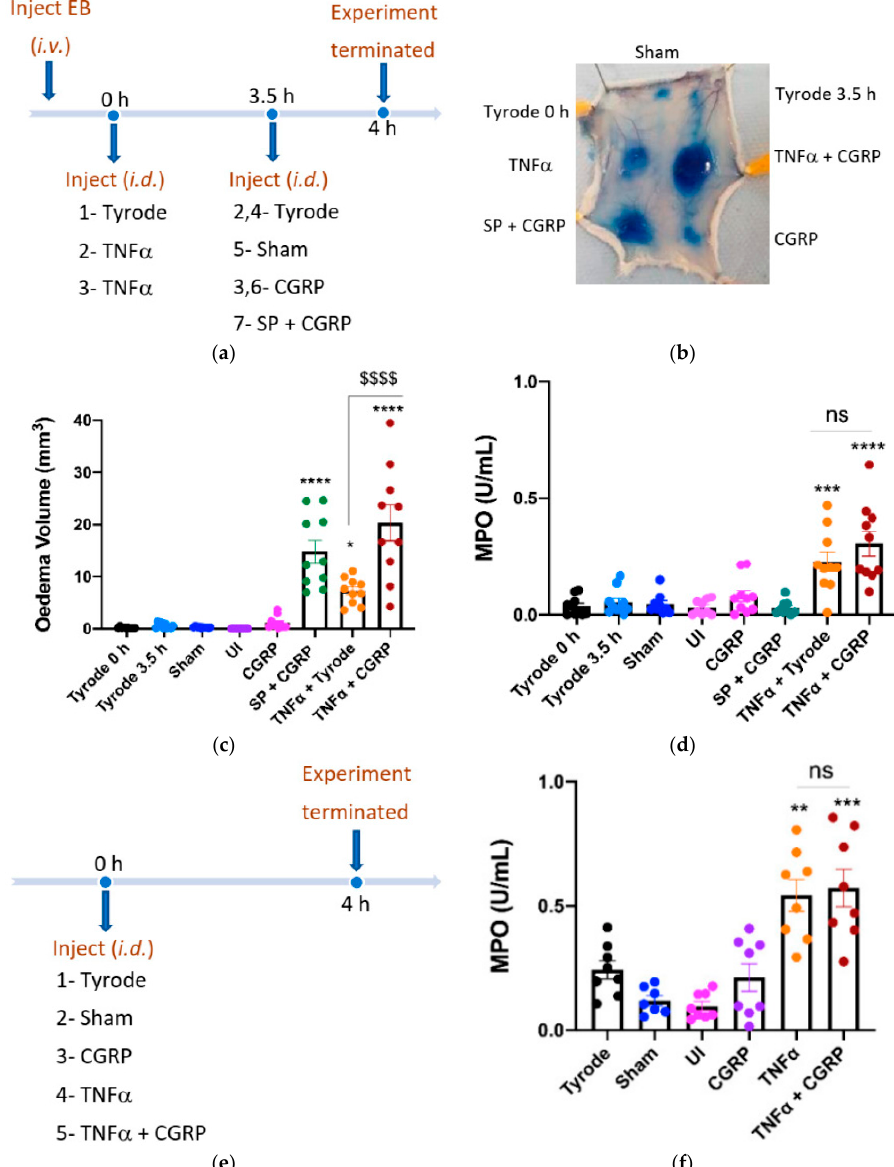
Figure 2. Calcitonin gene-related peptide, CGRP (when administered i.d. for the last 30 min) potentiates oedema formation, but not neutrophil accumulation induced by tumour necrosis factor alpha, TNF α , over 4 h. ( a ) Timeline for studying the effect of CGRP on TNF α -induced inflammation over 4 h, with CGRP or control added i.d. at the last 30 min (as c, d). ( b ) Representative image. Oedema volume ( c ) and neutrophil accumulation ( d ) were measured. This followed injection of TNF α (100 ng/50 µ L i.d.) or vehicle (Tyrode) at 0 h; then after 3.5 h vehicle (Tyrode) or CGRP (20 pmol/50 µ L i.d.) were injected at the TNF α sites. SP (300 pmol/50 µ L) was also injected with CGRP (20 pmol/50 µ L i.d.) at 3.5 h as a positive control for acute oedema formation. Results are shown as mean ± SEM ( n = 10). One-way ANOVA with Bonferroni’s post hoc test. * p < 0.05, *** p < 0.001, **** p < 0.0001 are compared to Tyrode 0 h or Tyrode 3.5 h. $$$$ p < 0.0001 is compared to TNF α + Tyrode. ( d ) Timeline for studying effect of CGRP when injected with TNF α at 0 h, for 4 h. ( e ) Timeline for studying the effect of CGRP on TNF α -induced inflammation over 4 h, with CGRP co-injected with TNF α i.d. at 0 h. ( f ) Neutrophil accumulation measured after co-injecting CGRP (20 pmol/50 µ L i.d.) with TNF α (100 ng/50 µ L i.d.) for 4 h. Results are shown as mean ± SEM ( n = 8). One-way ANOVA with Bonferroni’s post hoc test. ** p < 0.01, *** p < 0.001 are compared to